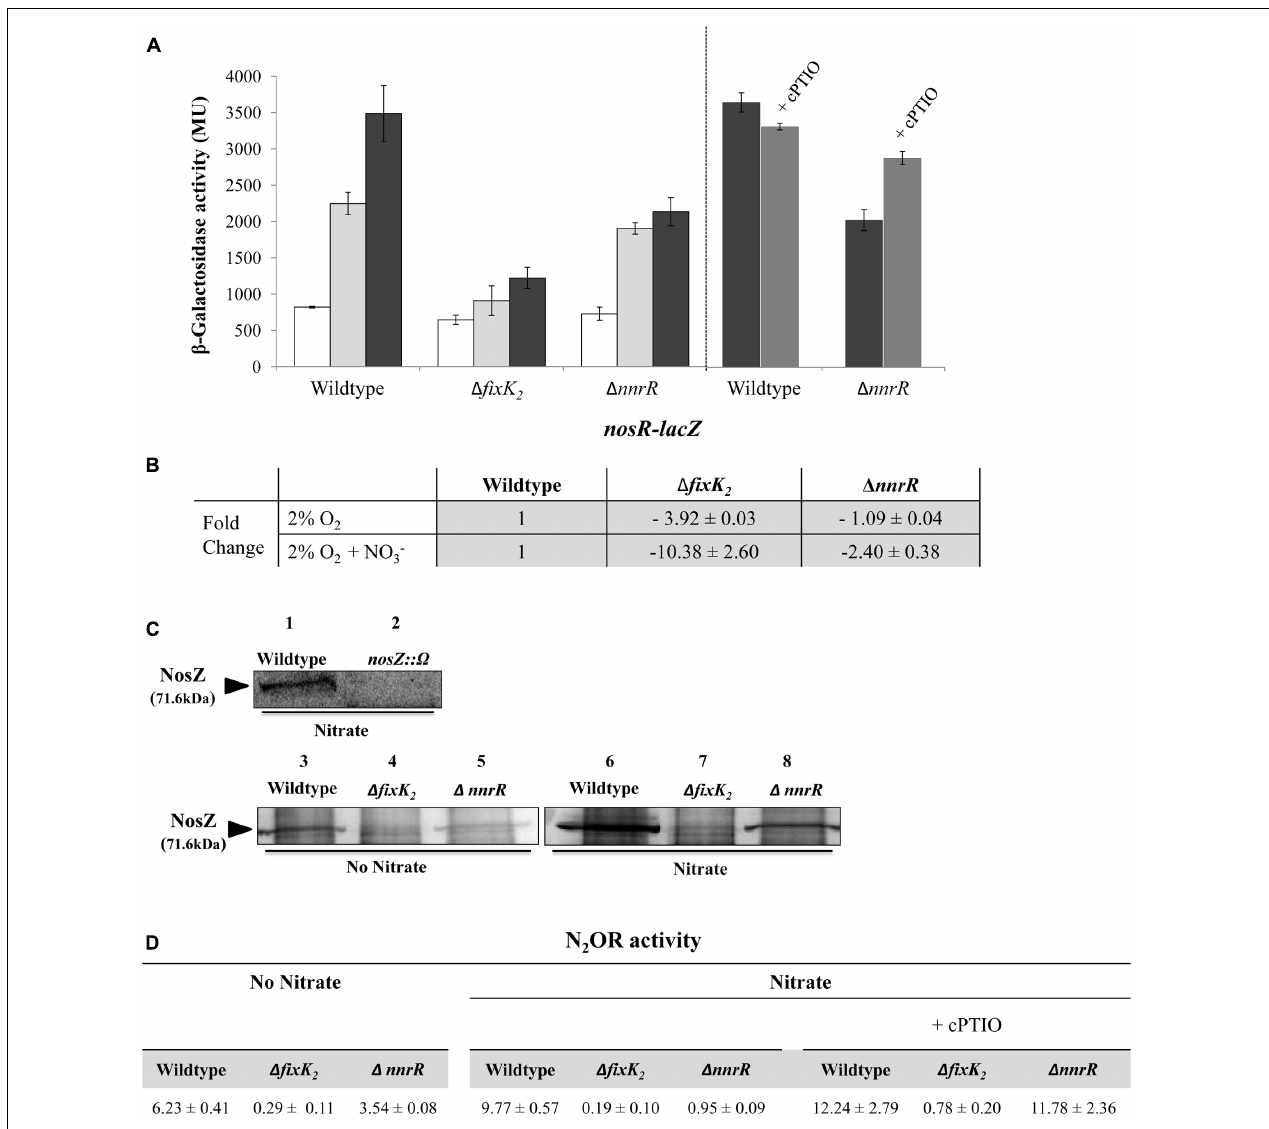
FIGURE 4 | Control of nosRZDFYLX expression by the regulatory proteins FixK 2 and NnrR. (A) β -Galactosidase activity expressed as Miller units (MU) from the nosR-lacZ transcriptional fusion chromosomally integrated in the B. diazoefficiens WT strain, and (cid:49) nnrR , and (cid:49) fixK 2 strains grown oxically (white bars), under 2% O 2 in the absence (light gray bars) or in the presence of 10 mM KNO 3 (black bars) for 24 h. In the right panel, 10 µ M of the NO-scavenger cPTIO was added to a series of cultures containing NO 3 − (dark gray bars). (B) Expression of nosR by qRT-PCR in the WT, and (cid:49) nnrR , and (cid:49) fixK 2 strains. qRT-PCR reactions were performed with cDNA synthesized from three independent RNA samples assayed in triplicate. Fold-change values refer to differences of expression in the (cid:49) nnrR , and (cid:49) fixK 2 mutants relative to the WT. (C) Western-blotted SDS-PAGE gels of the soluble fraction from the WT and (cid:49) nnrR , and (cid:49) fixK 2 strains probed with anti-NosZ antibody from Pa. denitrificans . As control, a B. diazoefficens nosZ mutant was used. The size of B. diazoefficiens NosZ is labeled on the left side. (D) Nitrous oxide reductase (N 2 OR) activity in the WT and (cid:49) nnrR , and (cid:49) fixK 2 strains expressed as nmol N 2 O consumed × (mg prot − 1 ) h − 1 . In (B–D) , cells were grown under 2% O 2 in the absence or in the presence of 10 mM KNO 3 during 24 h. 100 µ M of cPTIO was added to some of the cultures containing NO 3 − in (D) . In (A,B,D) , data shown as means with standard errors from at least two independent cultures, assayed in